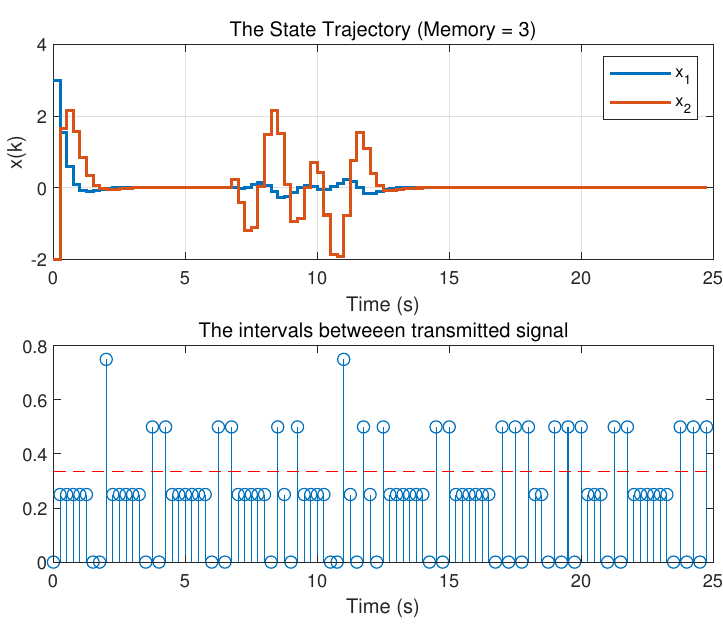
Figure 8. The state trajectories of the system for N =